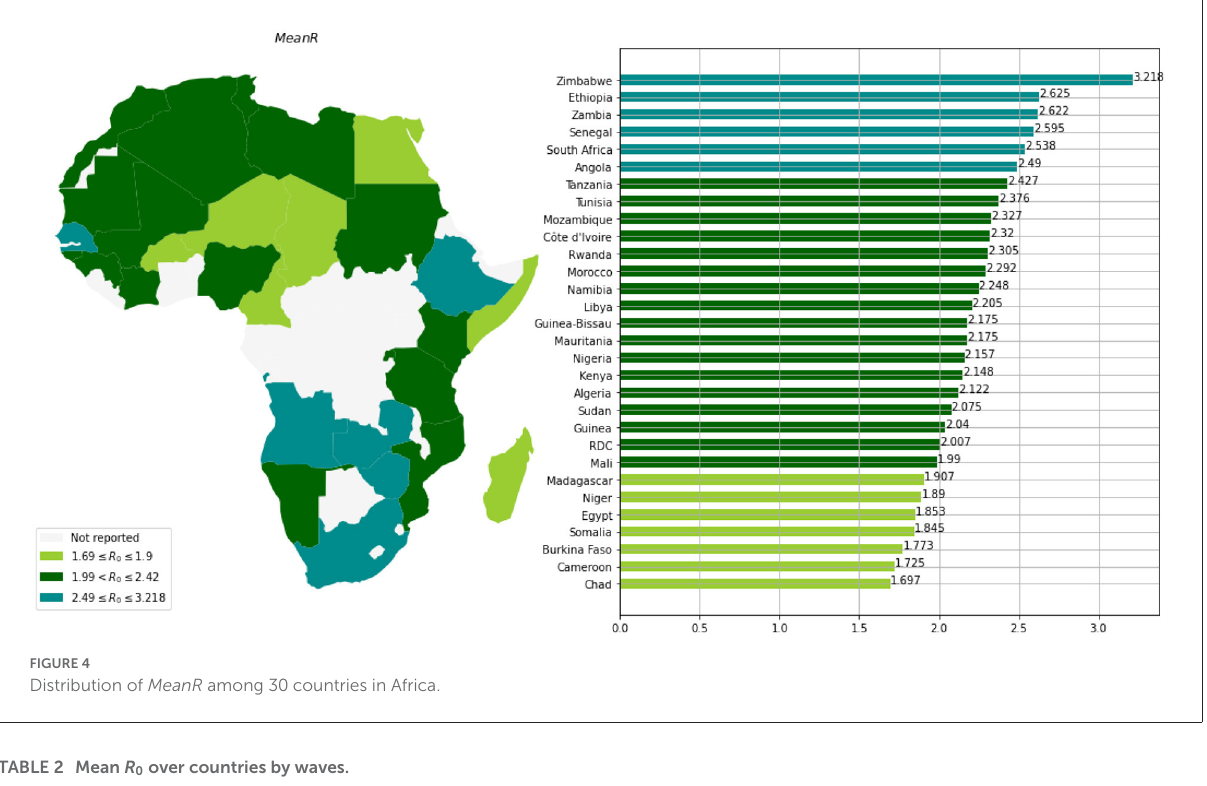
TABLE 2 Mean R 0 over countries by